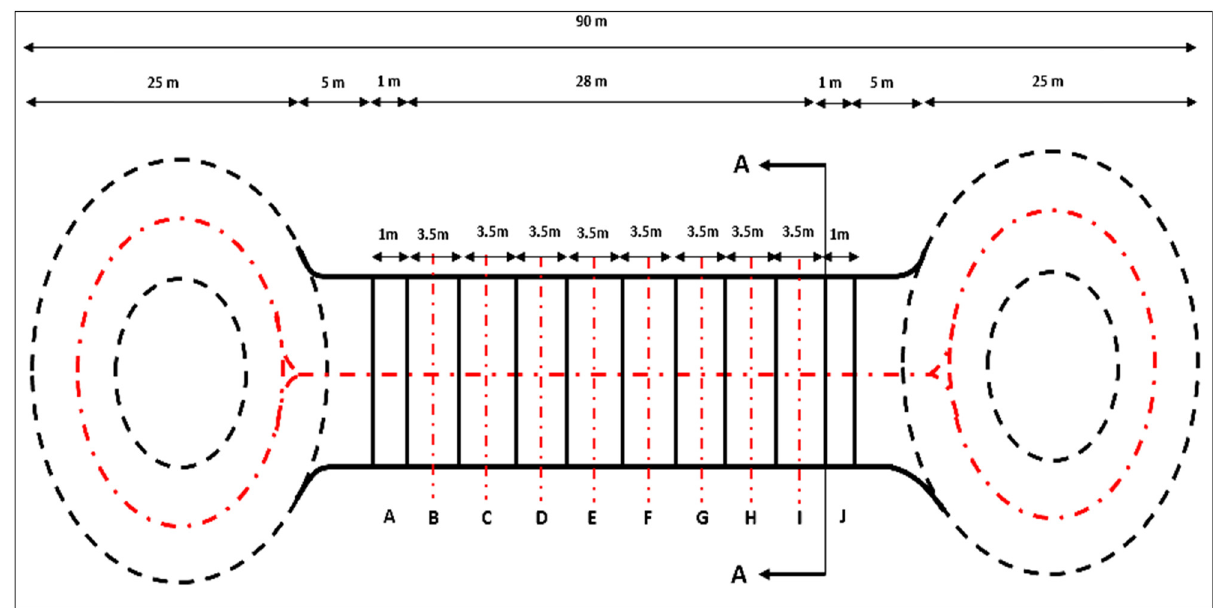
Figure 5: Full - scale road